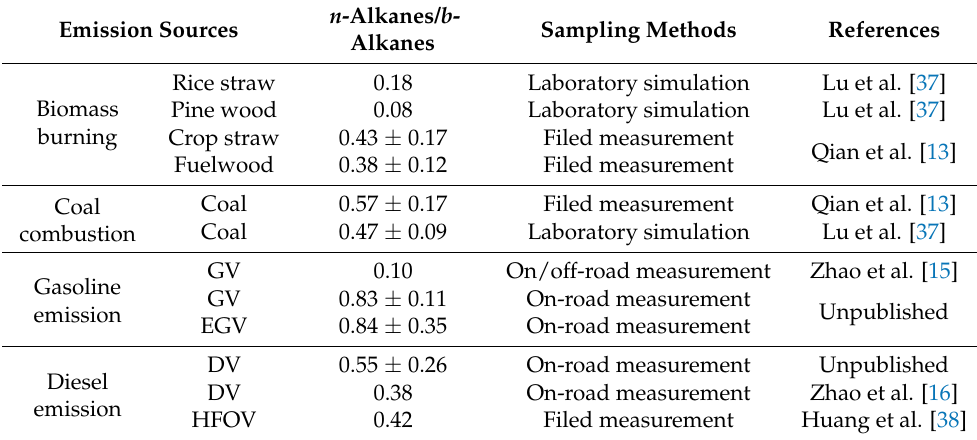
Table 1. Ratio of n -alkanes/ b -alkanes in source